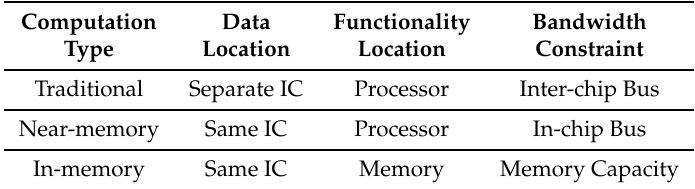
Table 1. Computation types with respect to